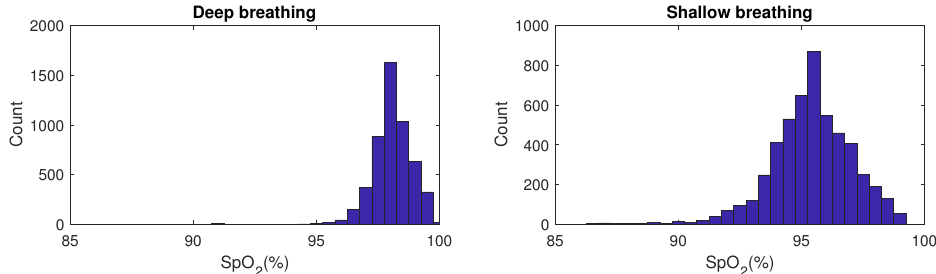
Figure 7. The breathing protocol used for the creation of our dataset, 3.5 min deep breathing followed by 3.5 min shallow breathing, leads to an average SpO 2 reduction of 3% with short-term desaturations as low as